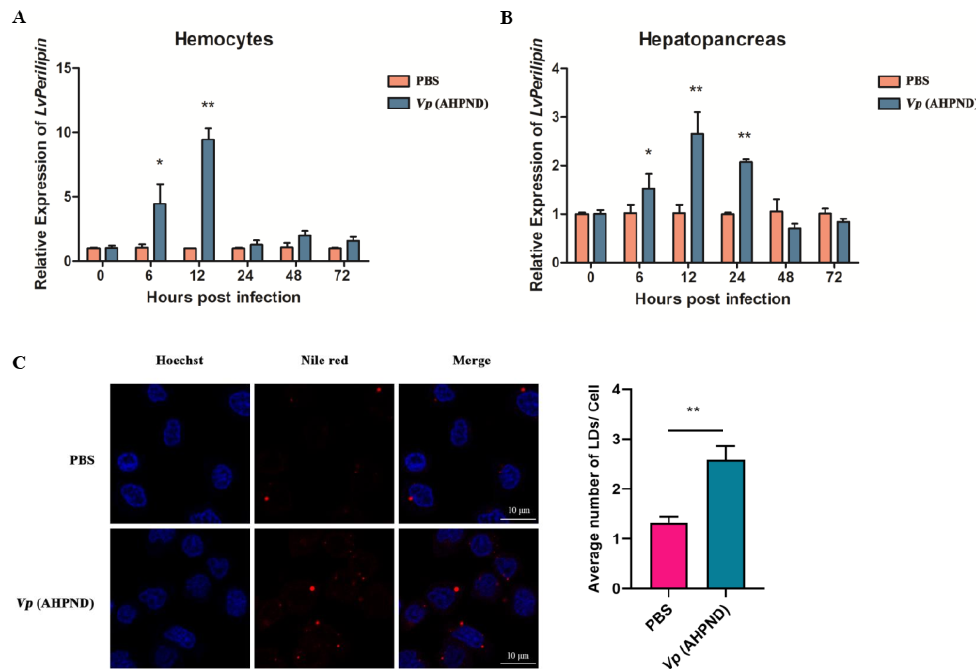
Figure 2. Vp (AHPND) infection increased Lv Perilipin expression and promoted LDs biogenesis. Expression of Lv Perilipin in shrimp hemocytes ( A ) and hepatopancreas ( B ) after Vp (AHPND) infection, as determined using qRT-PCR. Hemocytes and hepatopancreas were collected at 0, 6, 12, 24, 48, and 72 h post- Vp (AHPND) injection. The total RNA of each sample was extracted and synthesized for the first strand of cDNA. LvEF-1 α was used as the internal control. ( C ) Results of LDs staining using Nile red were observed from hemocytes of shrimps. The hemocytes were collected at 12 h after PBS (negative control) or Vp (AHPND) injection, subjected to LDs marking, and observed under a laser scanning confocal microscope. The average number of LDs per cell was quantified from ~100 cells. The figure is representative of three independent experiments. Statistical significance was set at * p < 0.05, ** p < 0.01. Scale bars = 10 μ m.